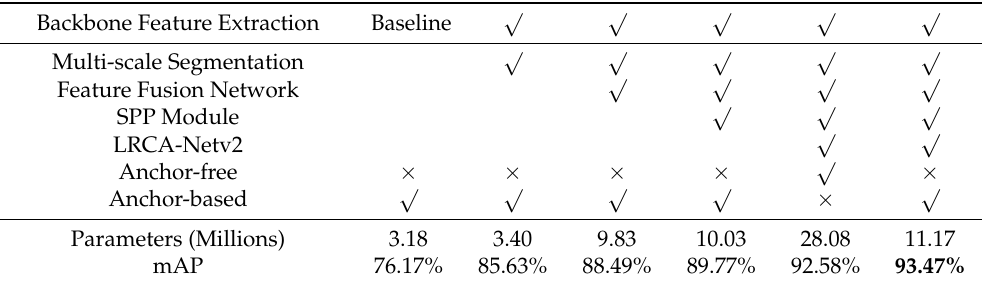
Table 2. Results of ablation experiments using the same data set, where bold numbers indicate the highest mAP, “ √ ” in each column indicates that the leftmost component is used in the model, and “ × ” indicates that the leftmost component is removed. The last number in each column represents the mAP obtained using the corresponding component.